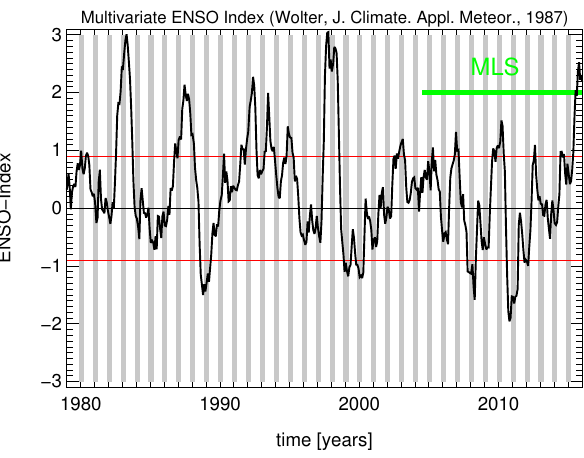
Figure 1. Multivariate ENSO Index (MEI) from the NOAA Climate Diagnostic Center, http://www.esrl.noaa.gov/psd/enso/mei (last ac- cess: 6 June 2018) (Wolter, 1987). The red lines denote the thresh- old values ( ± 0 . 9) defining the El Niño (positive) and La Niña (negative) composites as used in this paper. Grey shading shows winter seasons (December–February, DJF). Figure modified from Konopka et al.